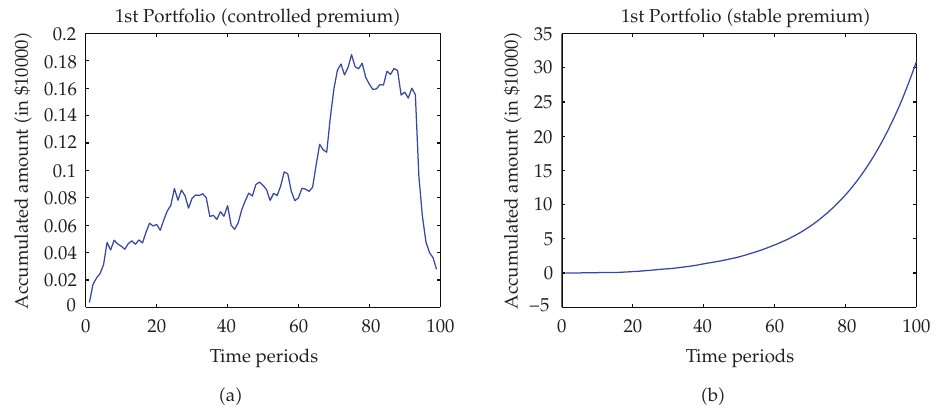
Figure 5: The accumulated profit/loss for (cid:5) stochastic (cid:7) controlled premium and stable premium, respectively, for the 1st class of a heterogeneous Portfolio for the respective incidents, during 100 unit- time period (cid:5) 300000 simulations (cid:7)